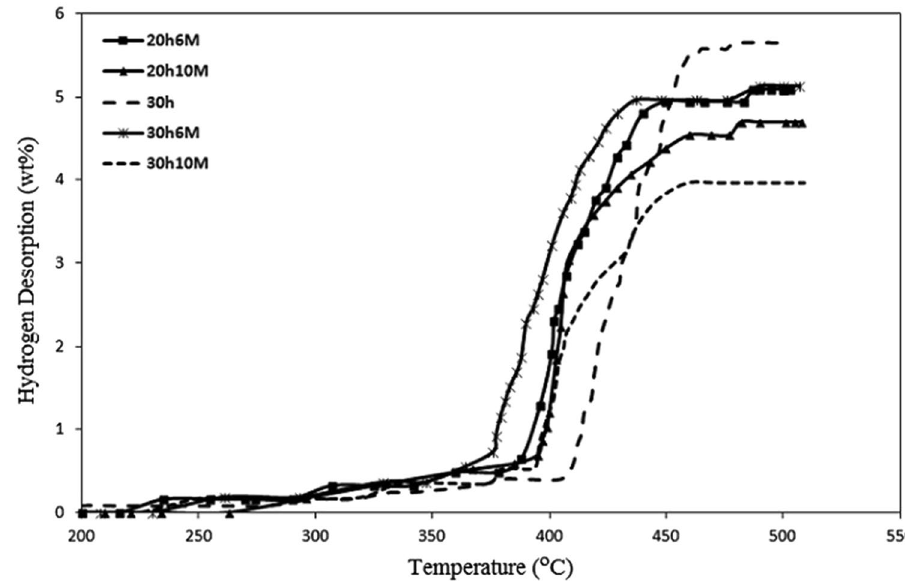
Fig. 13 Hydrogen desorption behavior of MgH 2 -6 wt% of mischmetal and MgH 2 -10 wt% of mischmetal milled for 20 and 30 h and also of the 30 h-milled MgH